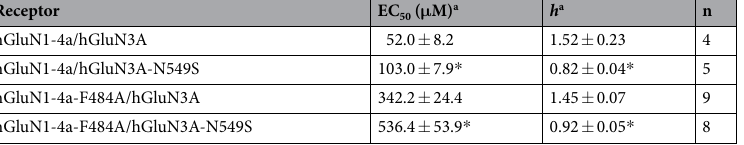
Table 2. Summary of the fitting parameters for the peak concentration-response relationship measured for wild-type and mutant hGluN1/hGluN3A receptors expressed in HEK293 cells (see Fig. 6h). a The EC 50 values and Hill coefficient (h) were obtained by fitting the normalized data from each cell using Equation (1). Data are presented as the mean ± SEM, and n corresponds to the number of cells recorded. Statistical analysis was performed for logEC 50 and logHill values; * p < 0.05 vs. hGluN1-4a/hGluN3A or hGluN1-4a-F484A/hGluN3A (Student’s